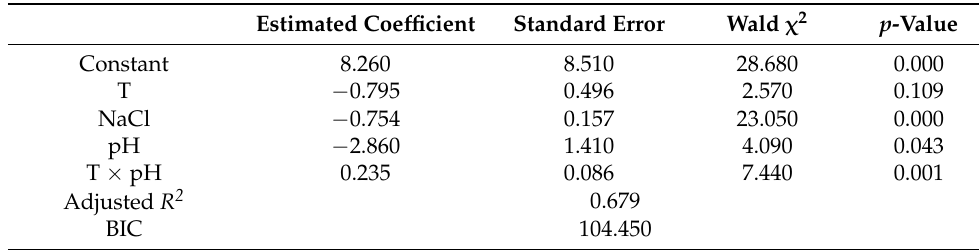
Table 2. Logistic regression of combined effect of T, pH, and NaCl on biofilm formation probability of L. monocytogenes ST9.